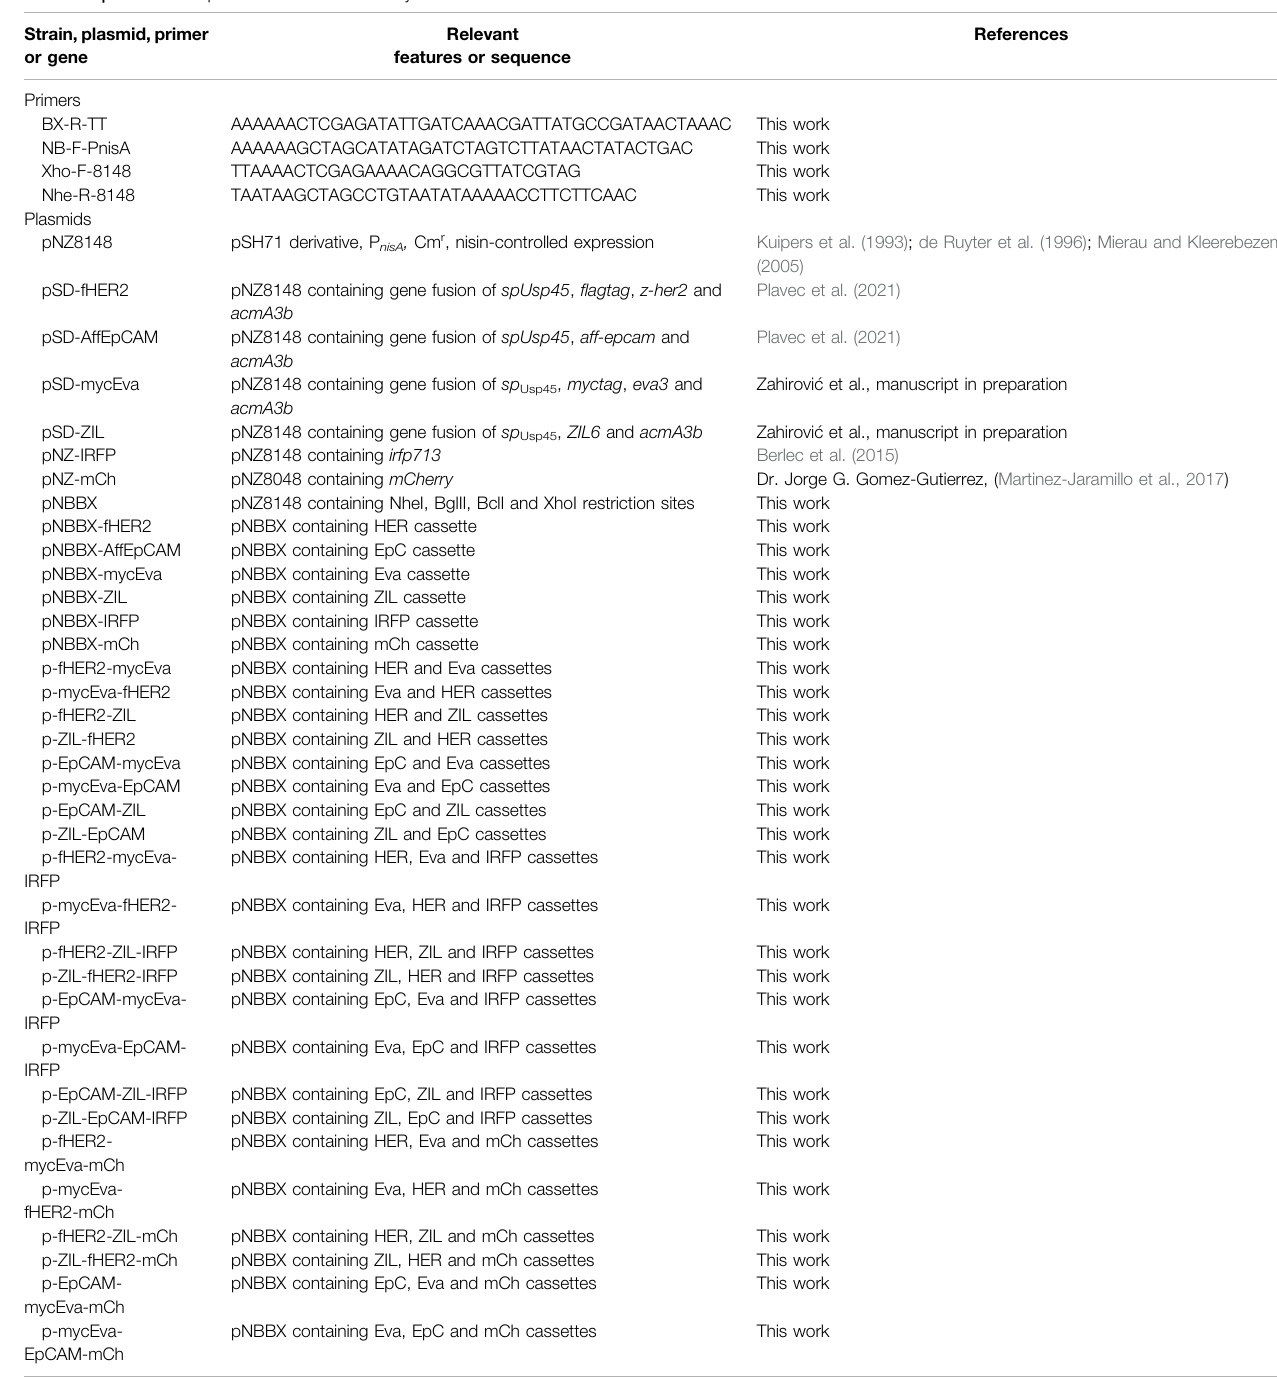
TABLE 1 | Primers and plasmids used in this